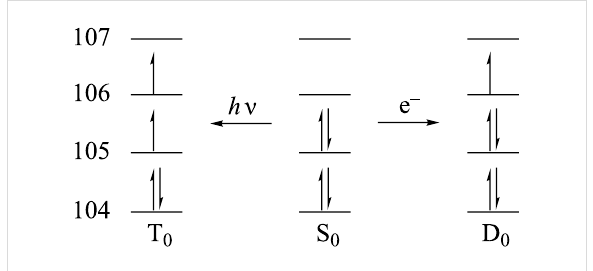
Figure 7: Frontier orbital occupancies of relevant electronic states of 3a . Note: the photochemical excited state may be T 0 (as pictured) or perhaps more likely S 1 (inverted spin in molecular orbital 106 relative to T 0 ), but T 0 is more computationally tractable and is equivalent to S 1 for orbital occupancy